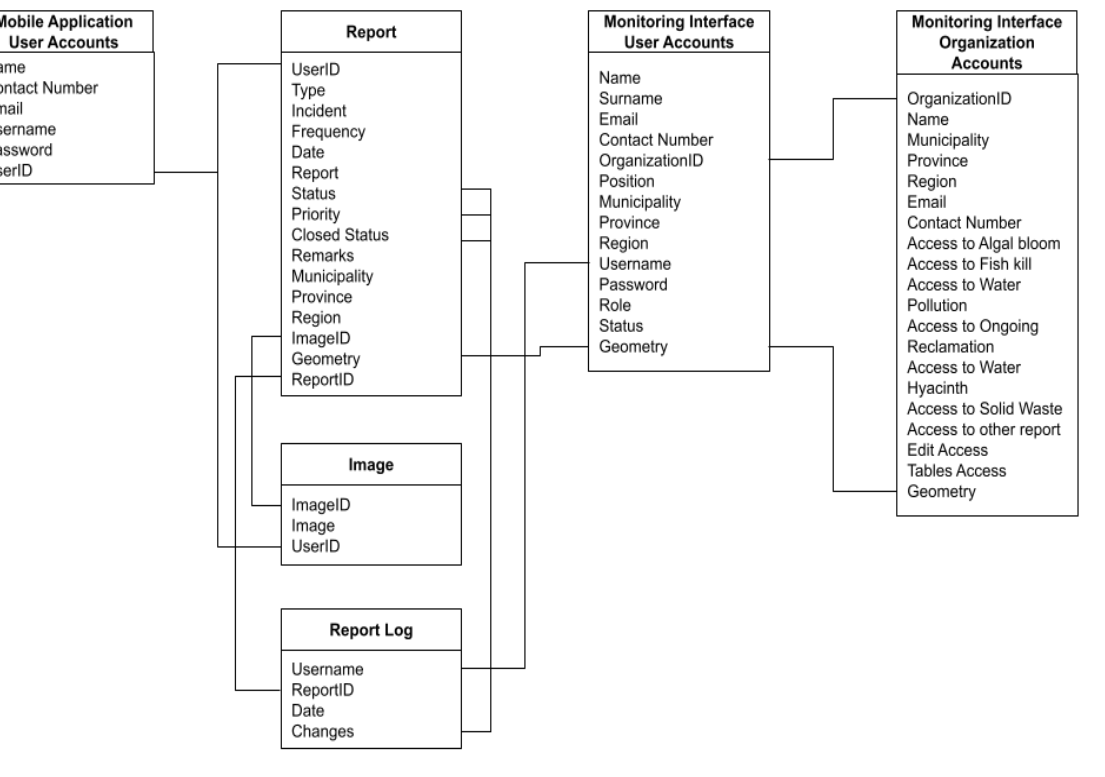
Figure 3. Data objects ER